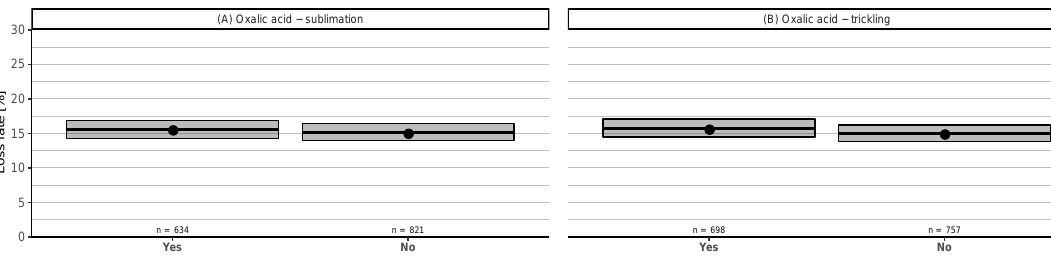
Figure A4. Treatment methods (yes = n > 19) used in autumn/winter 2018 (November–January) as single factors to winter honey bee colony loss rates (and 95% CI): To improve sample size, the oxalic mixture was added to oxalic